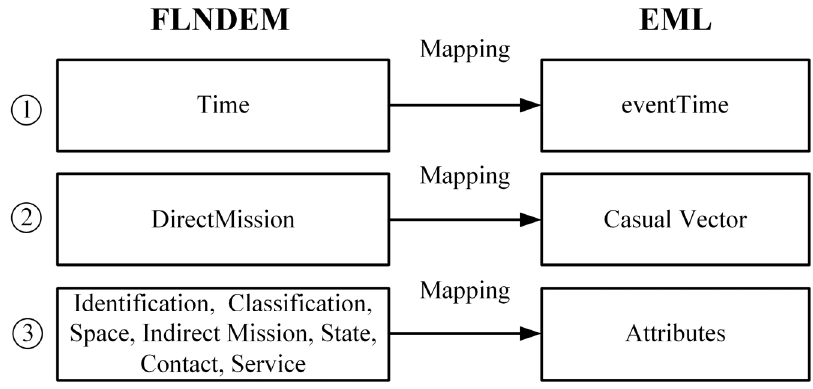
Figure 5. Mapping from FLCNDEM to event pattern markup language